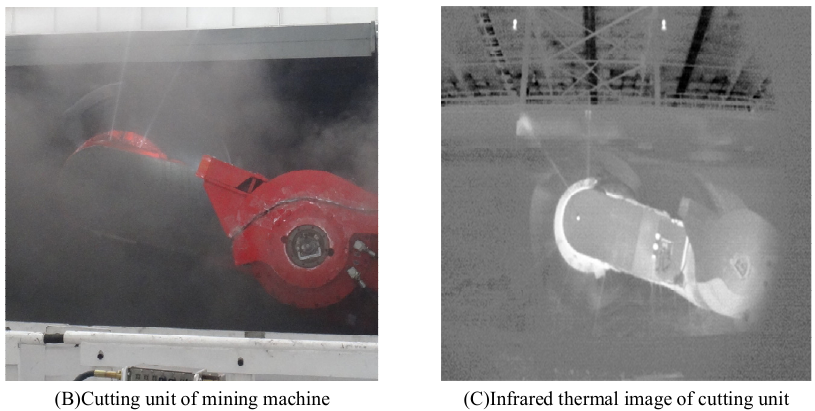
Figure 20. Original image form the surface experiment. ( A ) Image form surface mining engineering; ( B ) Cutting unit of mining machine; ( C ) Infrared thermal image of cutting unit.